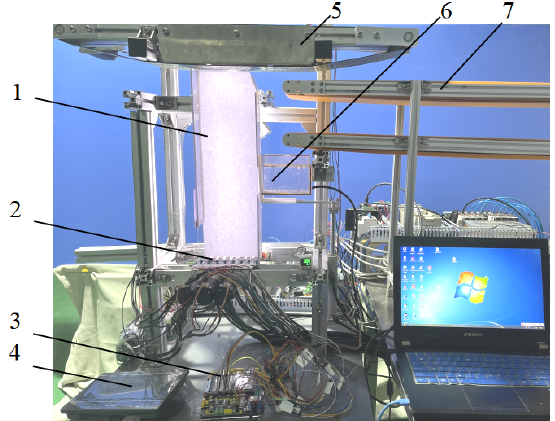
Figure 6. Experimental system showing the separation system of the collected seedlings using subdivided air streams: 1. separation container, 2. photosensitive sensor, 3. monitoring terminal, 4. touch screen controller, 5. picking belt, 6. delivery unit of individual separated seedlings, 7. delivery unit.